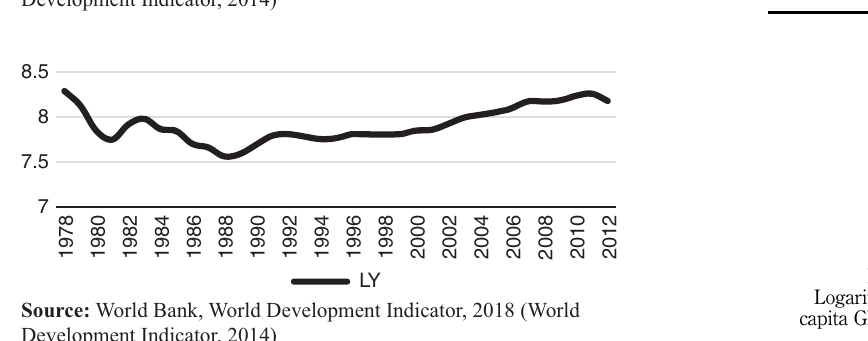
Figure 8. Logarithm of per capita CO 2 emissions in Iran